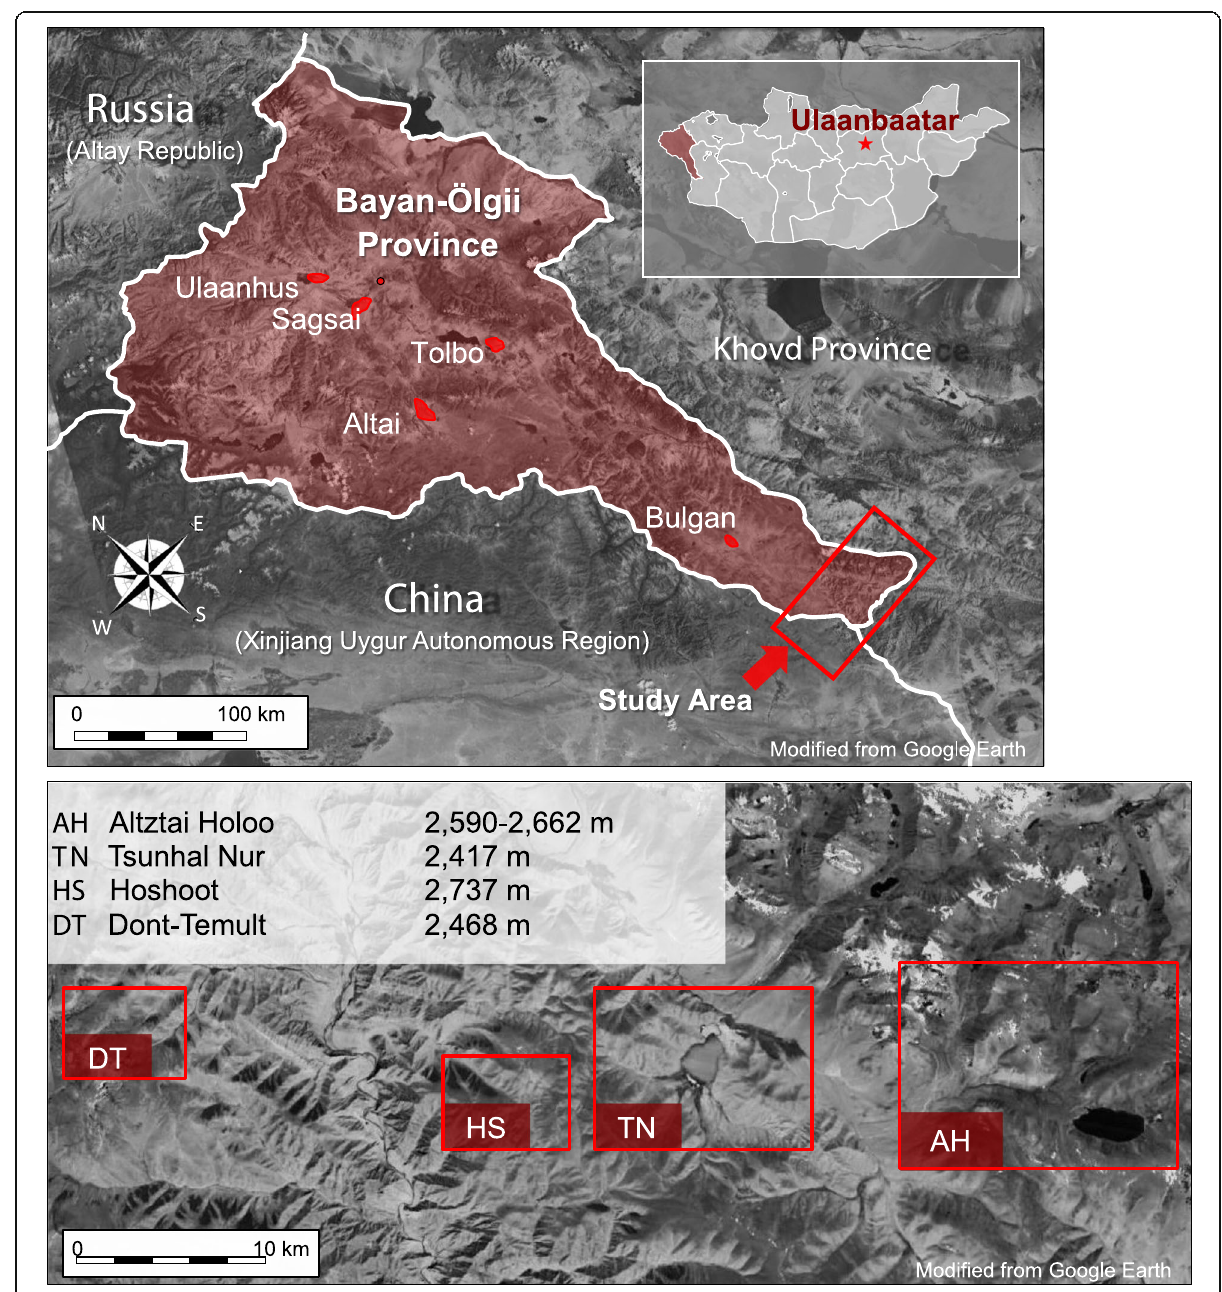
Figure 1 Location of the study region ( above ) within Mongolia (small inset) and of the four study sites in the Mongolian Altai ( below ). Sites DT, HS and TN are located in Bayan-Ölgii province; site AH is located in Khovd province. Image © 2014 Digital Globe; Landsat image, modified after download from Google